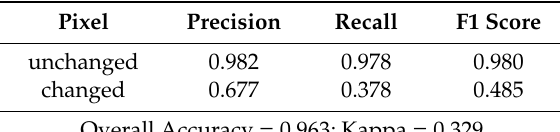
Table 4. The change detection accuracy in pixel level. Pixel Precision Recall F1 Score unchanged 0.982